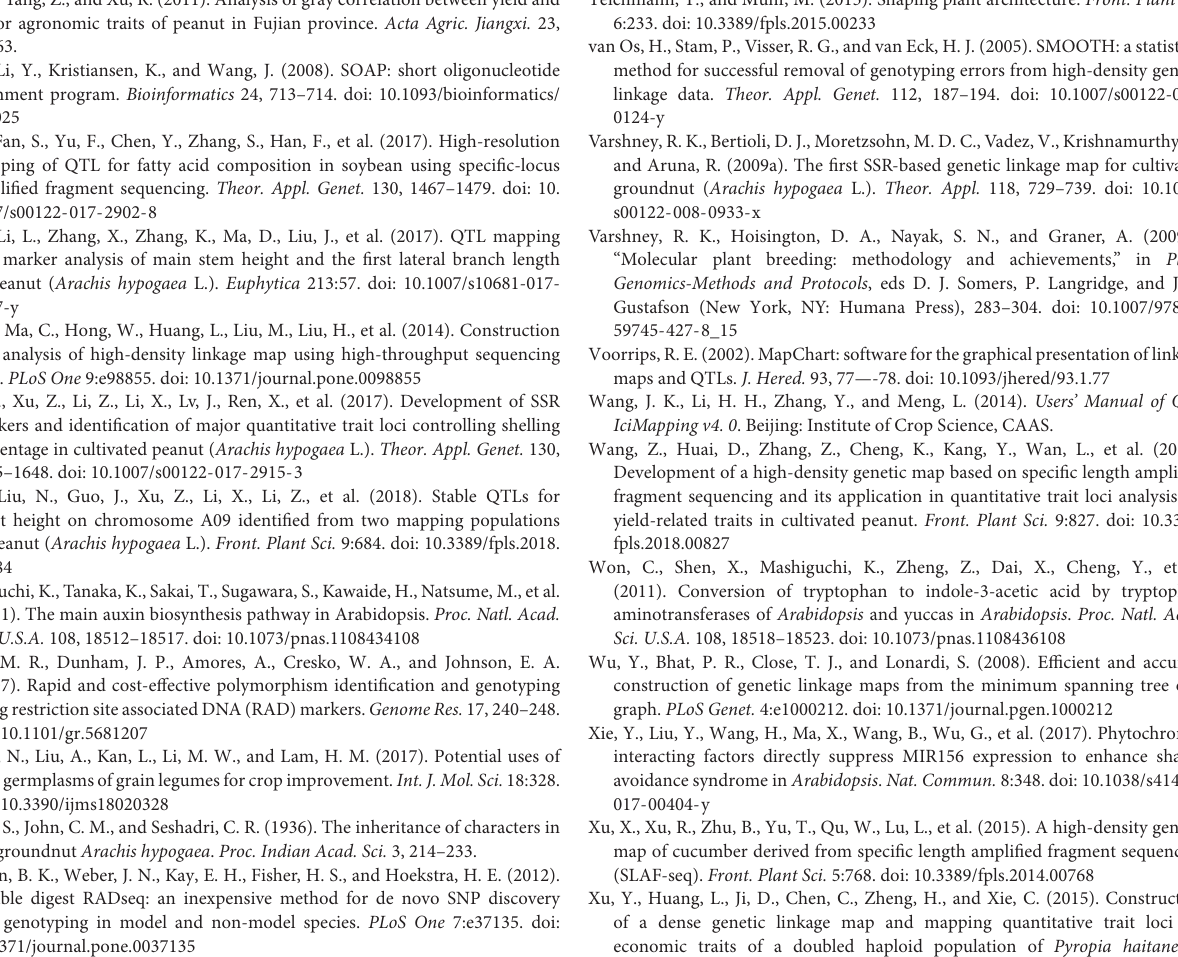
of a dense genetic linkage map and mapping quantitative trait loci for economic traits of a doubled haploid population of Pyropia haitanensis